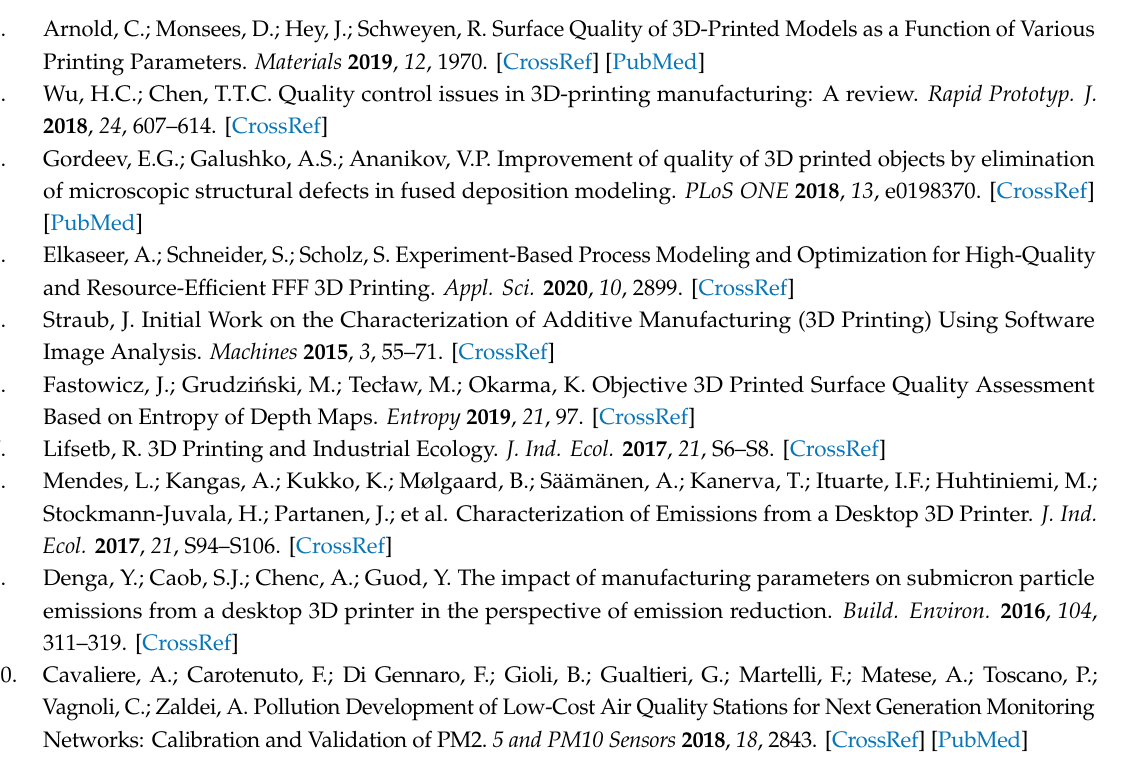
Table S1. Definition of the part probing strategy, Table S2. The experimental value for supports of the feature generated by 3D printing from solid design 3D element, Figure S1. Standardized Pareto Chart for Broken supports, Figure S2. Estimated Response Surface for broken supports, Figure S3. Standardized Pareto Chart for Flatness, Figure S4. Estimated Response Surface for Flatness, Table S3: The experimental value for dimension supports of the feature generated by 3D printing from solid design 3D element, Table S4: Dimensional value for correction the nominal dimension of the part body printed elements, Figure S5. Center point dimension for hole generated in sketch 2, Table S5: The experimental value for Flatness, Table S6: Analysis of Variance for Flatness, Figure S6: Estimated Response Surface for Flatness, Figure S7: Estimated Response Surface for Flatness, Figure S8: Estimated Response Surface for Flatness, Figure S9: Estimated Response Surface for Straightness_X1, Figure S10: Estimated Response Surface for Straightness_X1, Figure S11: Estimated Response Surface for Straightness_X1, Figure S12: Estimated Response Surface for Straightness_X2, Figure S13: Estimated Response Surface for Straightness_X2, Figure S14: Estimated Response Surface for Straightness_X2, Figure S15: Estimated Response Surface for Straightness_Y1, Figure S16: Estimated Response Surface for Straightness_Y1, Figure S17: Estimated Response Surface for Straightness_Y1, Figure S18: Estimated Response Surface for Straightness_Y2, Figure S19: Estimated Response Surface for Straightness_Y2, Figure S20: Estimated Response Surface for Straightness_Y2, Figure S21: Estimated Response Surface for Roundness for Hole_15, Figure S22: Estimated Response Surface for Roundness for Hole_15, Figure S23: Estimated Response Surface for Roundness for Hole_15, Figure S24: Estimated Response Surface for Roundness for Circle_15_2, Figure S25: Estimated Response Surface for Roundness for Circle_15_2, Figure S26: Estimated Response Surface for Roundness for Circle_15_2, Table S7: The experimental value for dimension supports of the feature generated by 3D printing from solid design 3D element - Straightness, Table S8: The experimental value for dimension supports of the feature generated by 3D printing from solid design 3D